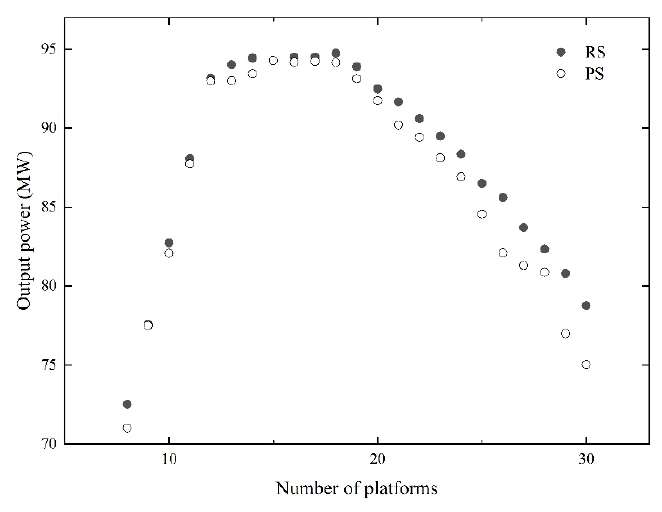
Figure 8. Optimized power from random search (RS) and pattern search (PS) algorithms.